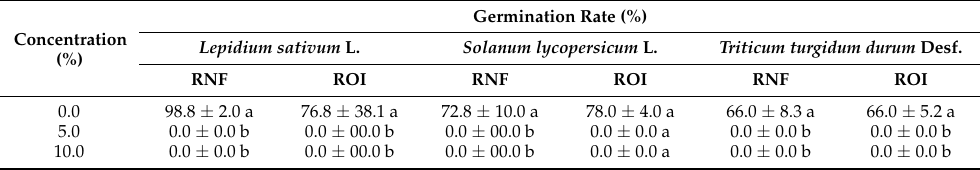
Table 5. Effects of different concentrations of retentates on pre-germinated seeds of cress, tomato, and durum wheat